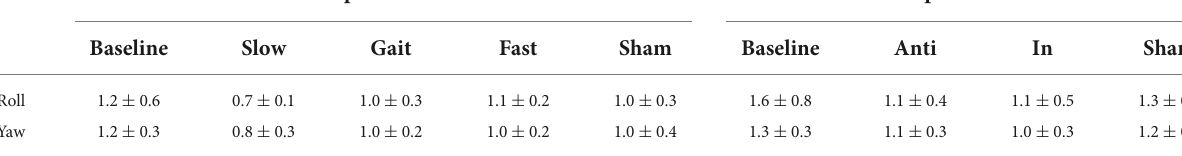
TABLE 1 Peak frequencies of periodic postural response on the roll and yaw axes in each condition in Experiments 1 and 2 (mean ± SD). Experiment 1 Experiment 2 Baseline Slow Gait Fast Sham Baseline Anti In